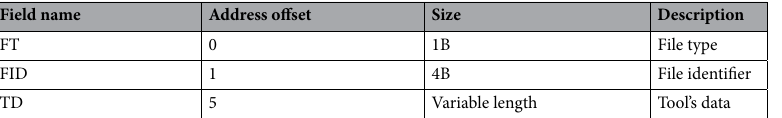
Table 2. Tool file format. As with the data file, the first field FT specifies file type, the second field FID is the identifier of the file, and the third field TD is a variable-length field, which stores the data of the